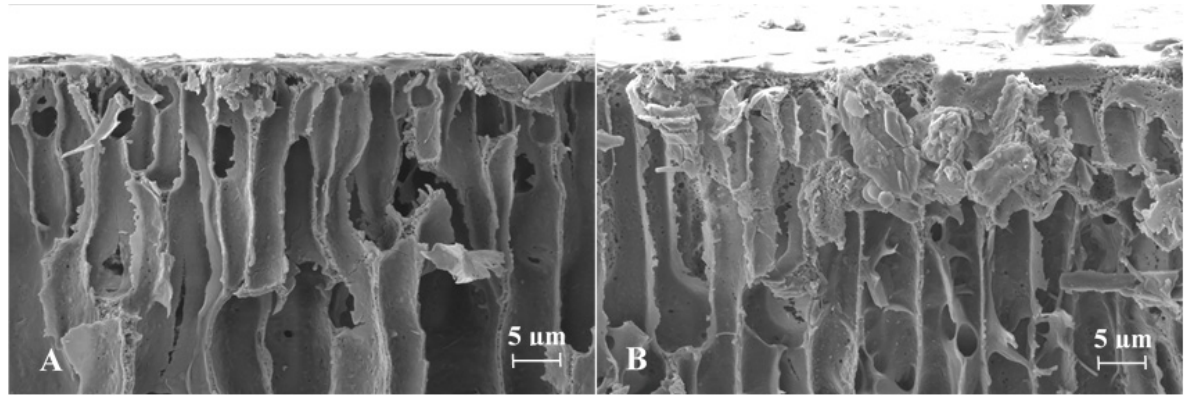
Figure 3. Scanning electron microscopy cross-section image of the finger-like pores at the surface of spherical in situ forming gels prepared for formulations containing 200 mg eq./g bedaquiline fumarate salt in PLGA5050A/NMP 20/80% ( w / w ) (Panel ( A ), formulation 1) and in PLGA7525A/NMP 20/80% ( w / w ) (Panel ( B ), formulation 2).